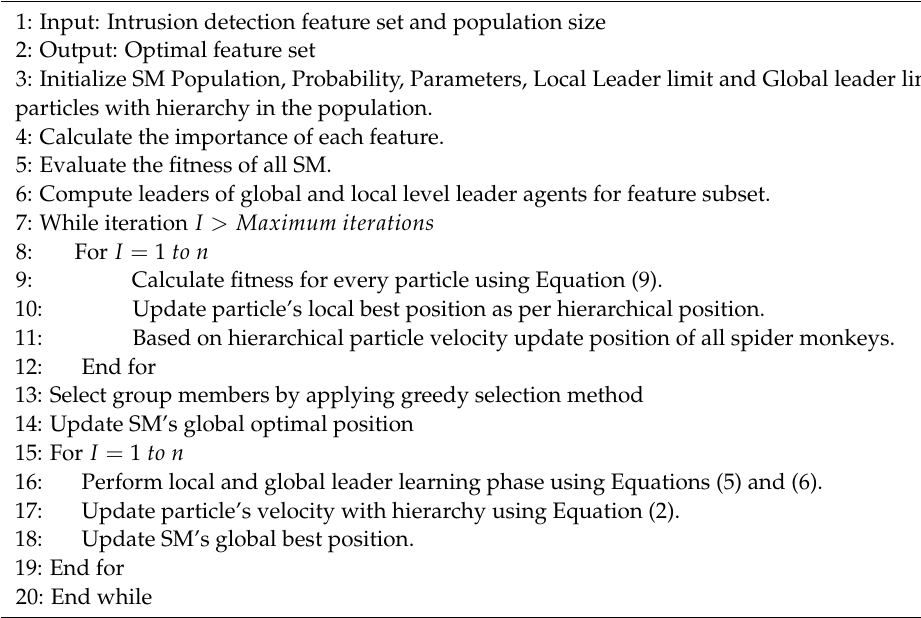
Algorithm 1: Hybrid